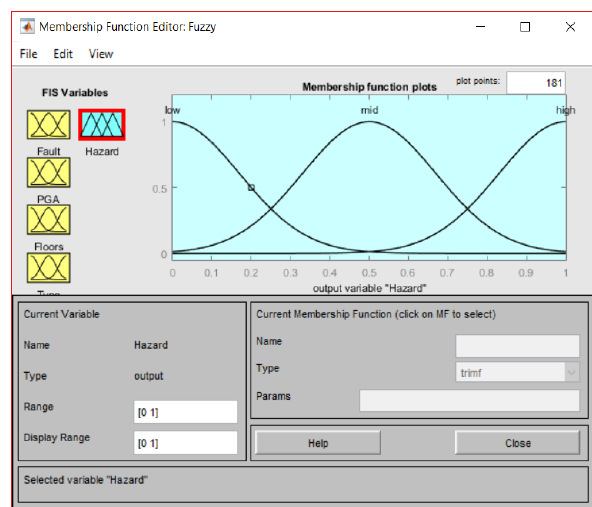
Figure 10. Damage membership function